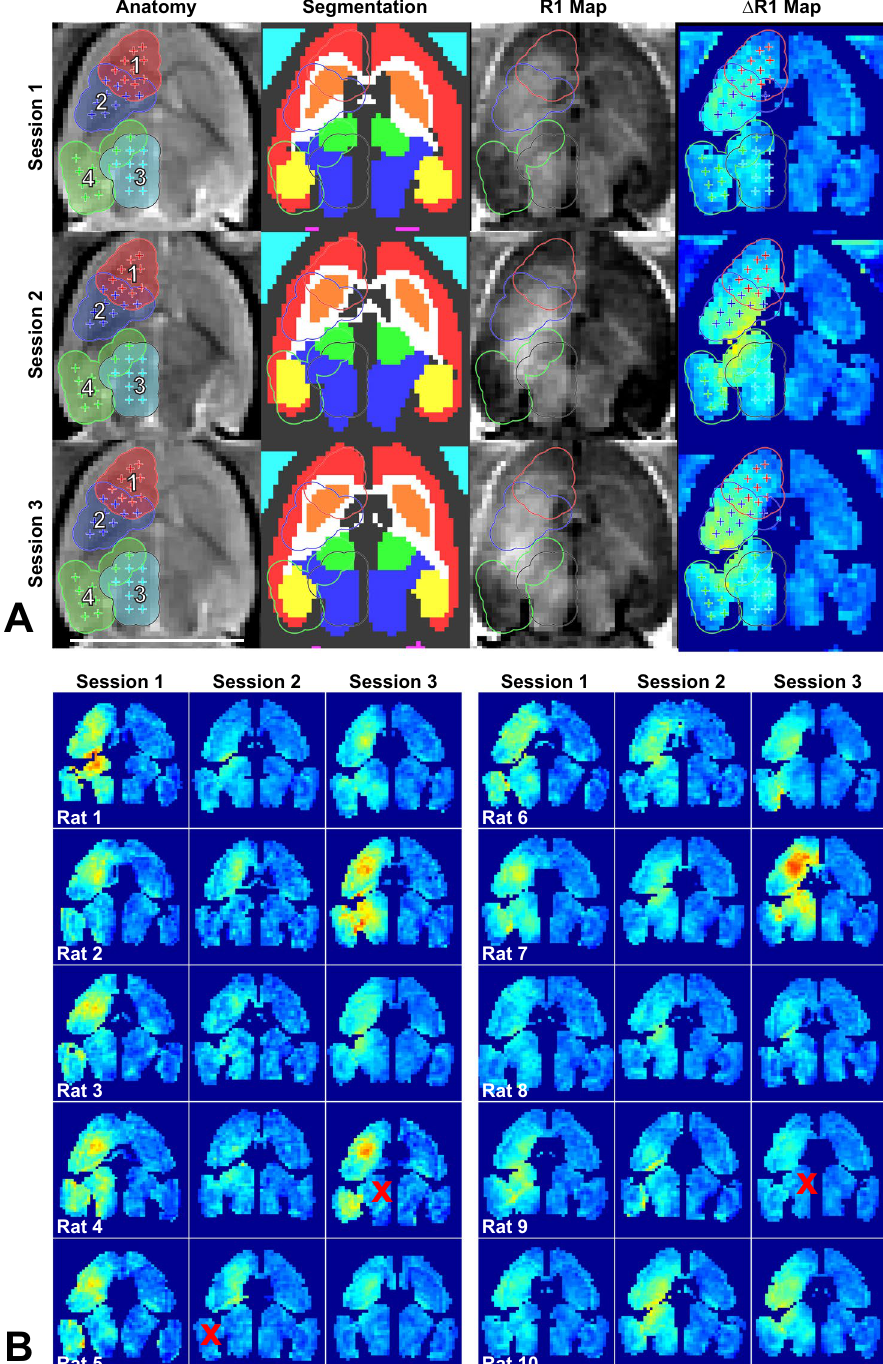
Figure 4. R1 mapping to visualize Gadavist delivery across the BBB over three sessions in 10 rats. ( a ) Anatomic images, segmentations of different brain structures, R1 maps and Δ R1 maps for one rat over three weekly sessions. The 36 sonication targets are indicated on the anatomy images. The contours indicate a 1.25 mm radius around each target for the four volumetric sonications. These contours, along with segmentations of different structures, were used to create Δ R1 maps. The Δ R1 maps show differences in R1 between the sonicated and control hemisphere. (In the segmentation: red = cortex, orange = striatum, white = white matter, green = thalamus, blue = pons, yellow = hippocampus, cyan = non-sonicated muscle) ( b ) Δ R1 maps for 30 consecutive sessions in ten rats. While there was considerable variability, in almost every tissue structure within the sonicated volumes the mean R1 was significantly (P < 0.05) higher when comparing the two hemispheres. The difference was not significant in the thalamus in two sessions and in the hippocampus in one session (indicated by red “x”